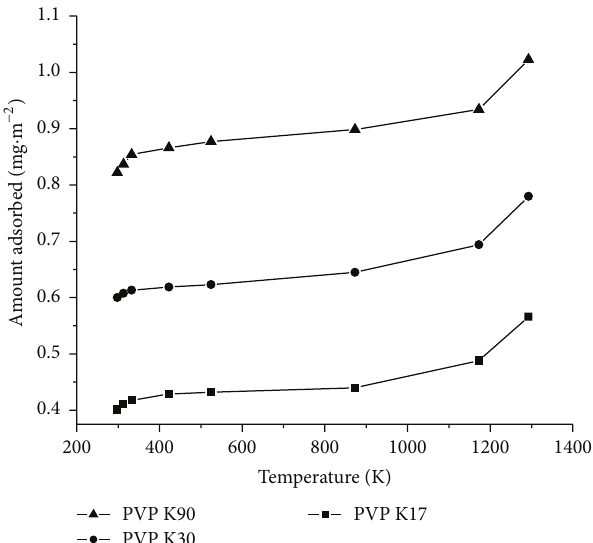
Figure 12: Effect of PVP concentration and molecular mass over the zeta potential of silica. The error percentage was about 5.0.